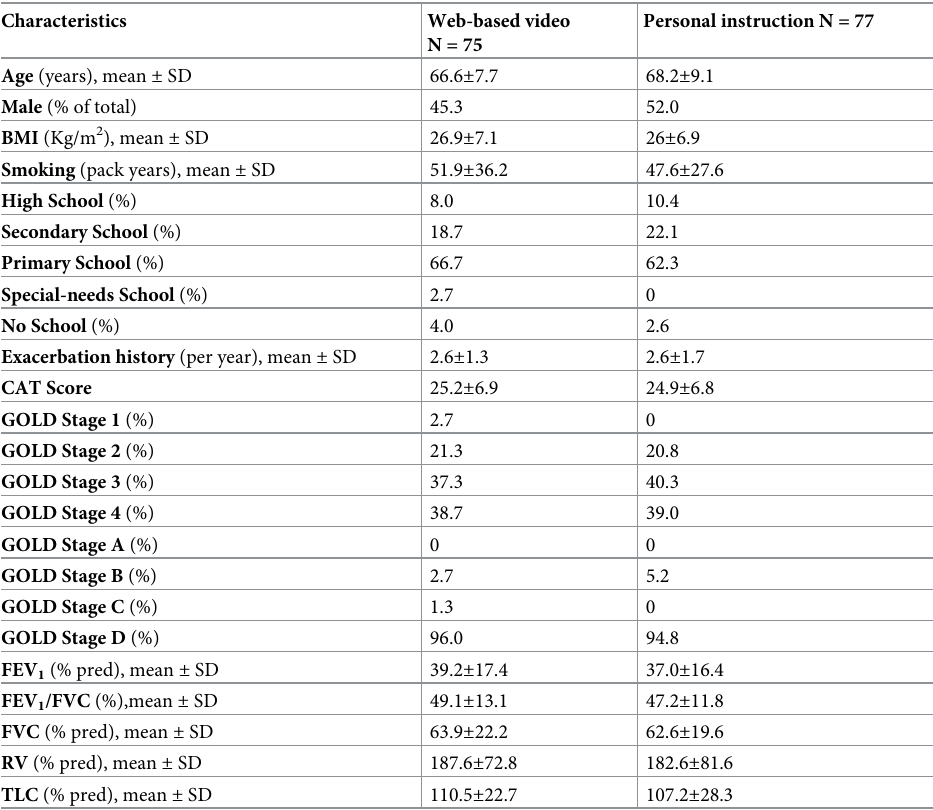
Table 1. Demographic data and GOLD stages (N = 152).